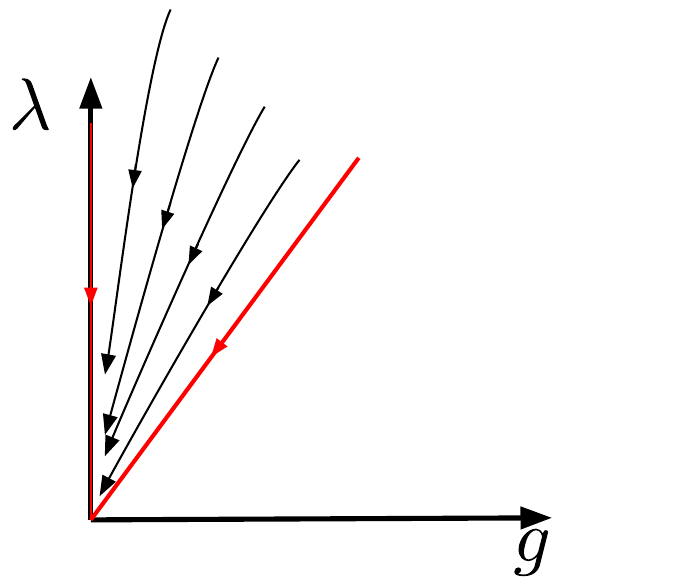
Figure 12 . The RG flow is bounded by the separatrix solutions g = αλ with α given in (A.4) and drawn as red lines. The separatrices form a funnel which guaranties that the fixed point is reached as long as the flow is started within the